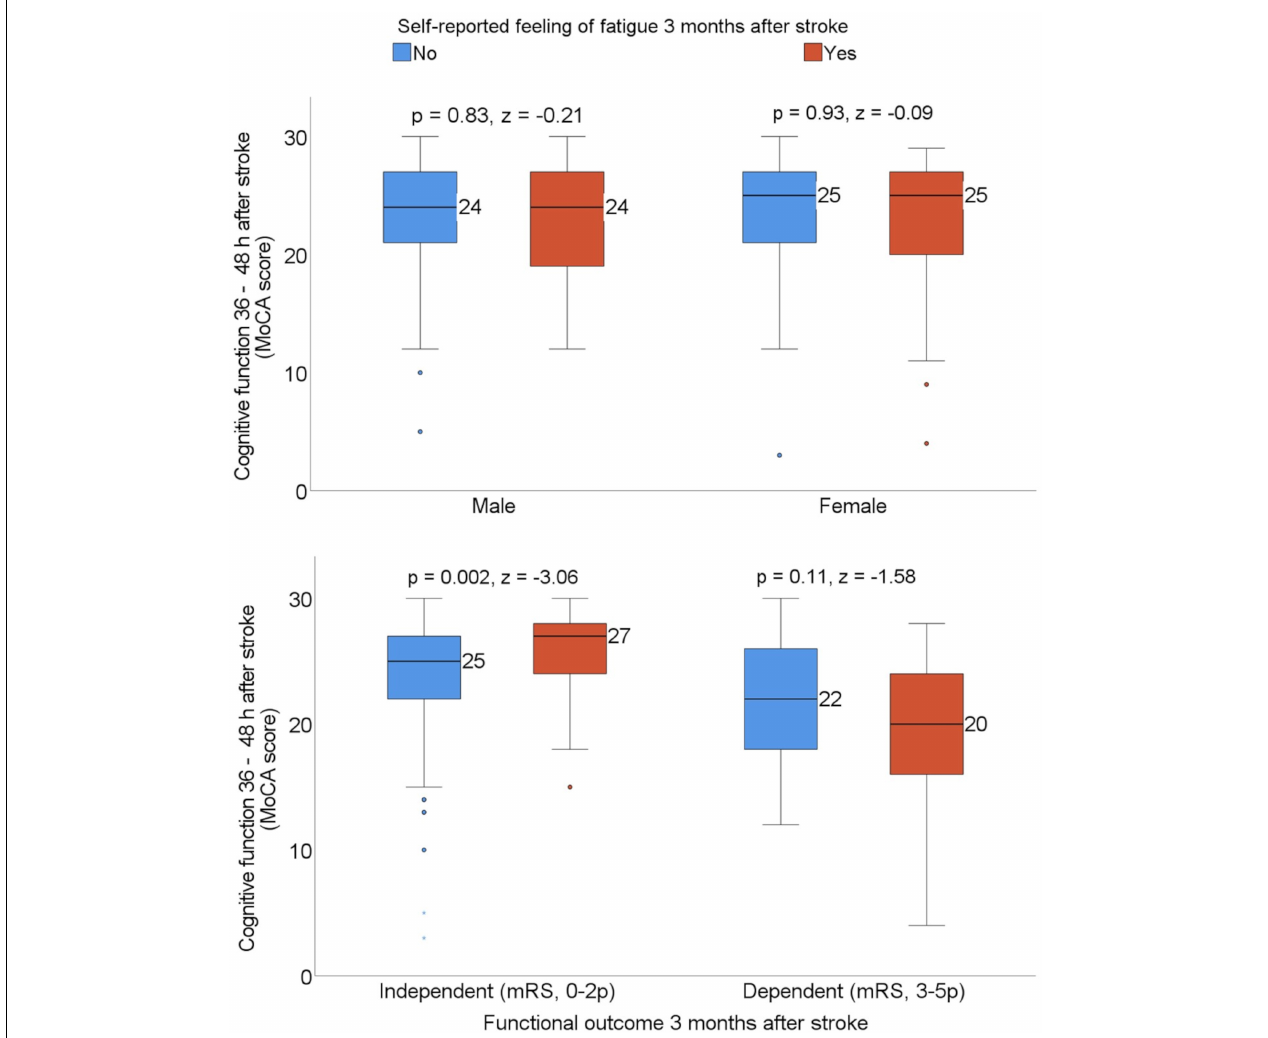
FIGURE 3 | Box plots showing the median Montreal Cognitive Assessment (MoCA) score by sex and patients who were dependent vs. independent 3 months after stroke, stratified with the self-reported feeling of fatigue. Statistics were determined by the Mann-Whitney U test. mRS, modified Rankin